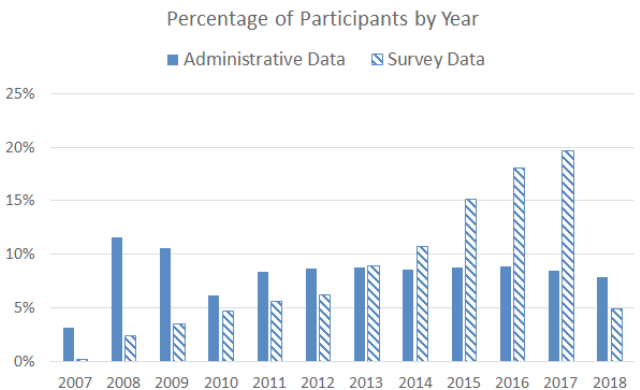
Table 1: Counts, percentage of respondents, and calculated weights by year of participation